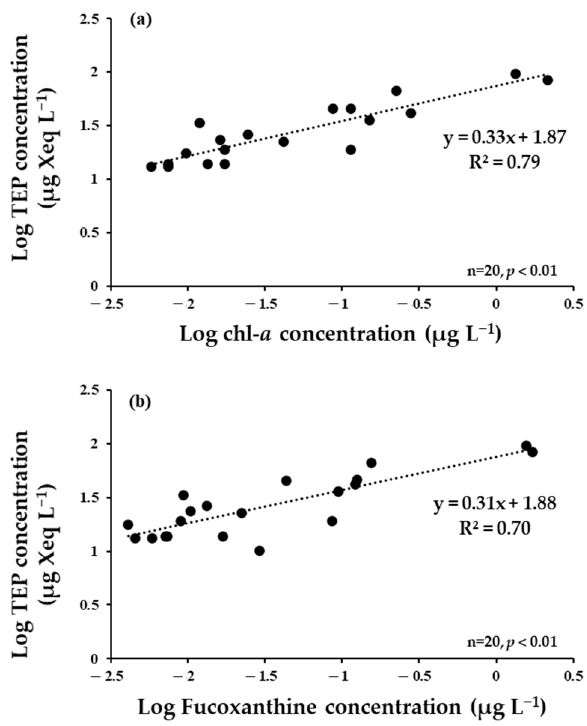
Figure 9. Correlations between log TEP concentrations and log Chl- a ( a ) and between log TEP concentrations and log fucoxanthine ( b ) at the JBS during our sampling period.